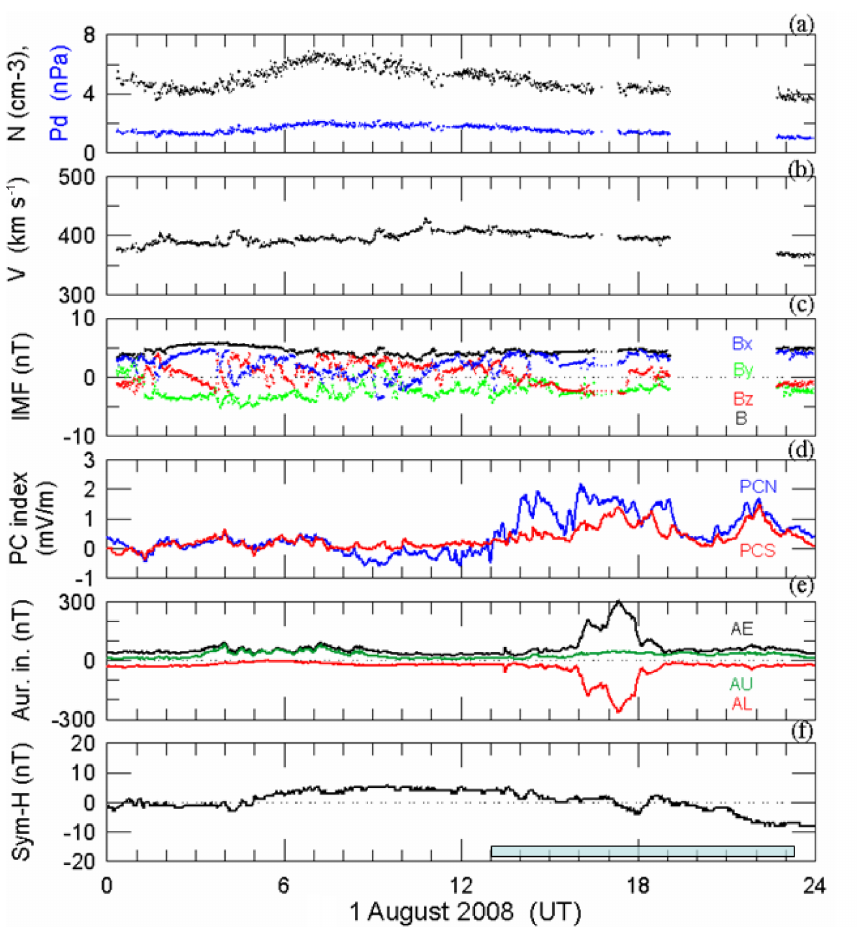
Figure 3. Solar wind parameters from OMNI data and geomagnetic indices on 1 August 2008. From top to bottom: (a) solar wind density (black) and dynamic pressure (blue), (b) solar wind speed, (c) interplanetary magnetic field (IMF) components B x (blue), B y (green), B z (red), and magnitude B (black) in geocentric solar magnetospheric (GMS) coordinates, (d) polar cap magnetic activity index PCN for the Northern Hemisphere (blue) and PCS for the Southern Hemisphere (red), (e) auroral electrojet index AE (black), AL (red), and AU (green), and (f) storm-time ring current variation index SYM-H. The shaded box denotes the time interval from 13:00 to 23:00UT, when the non-storm FEE enhancements were